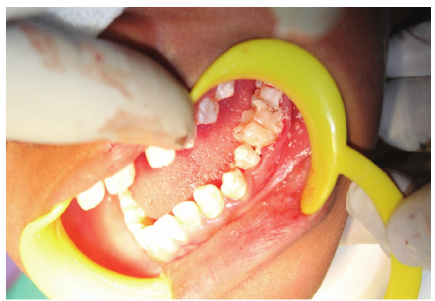
Figure 12: Placement of osseograft in relation to